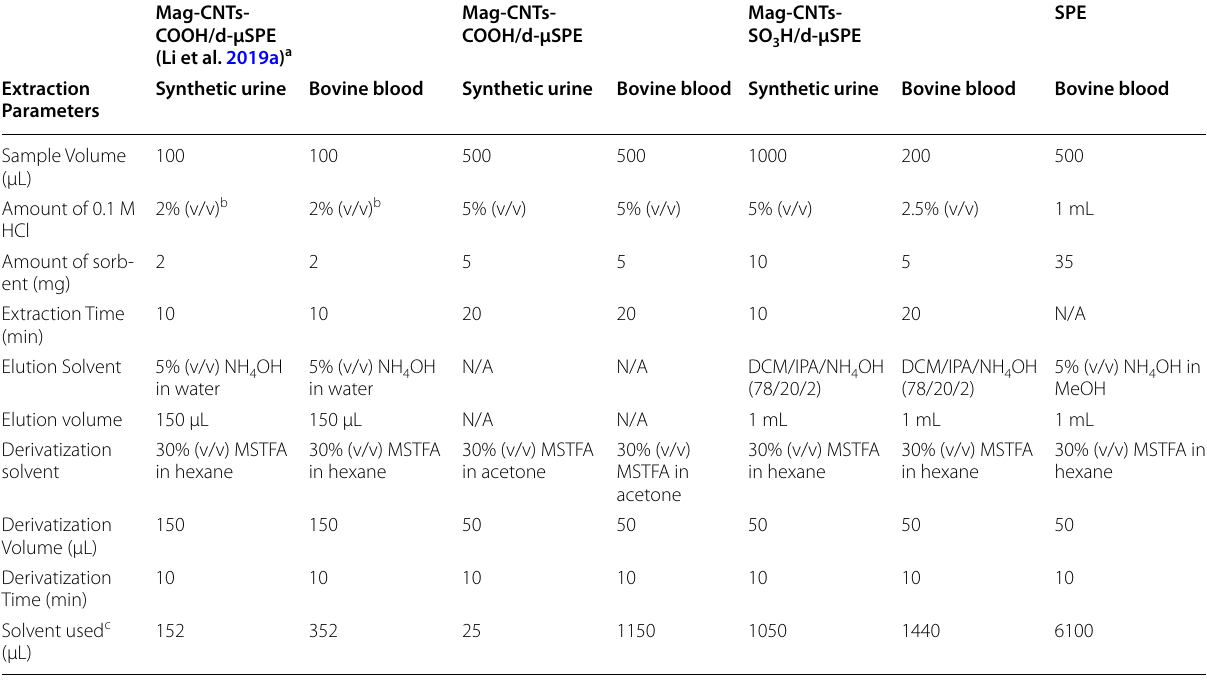
Table 1 Extraction parameters for the two Mag-CNTs/d-µSPE methods and the SPE